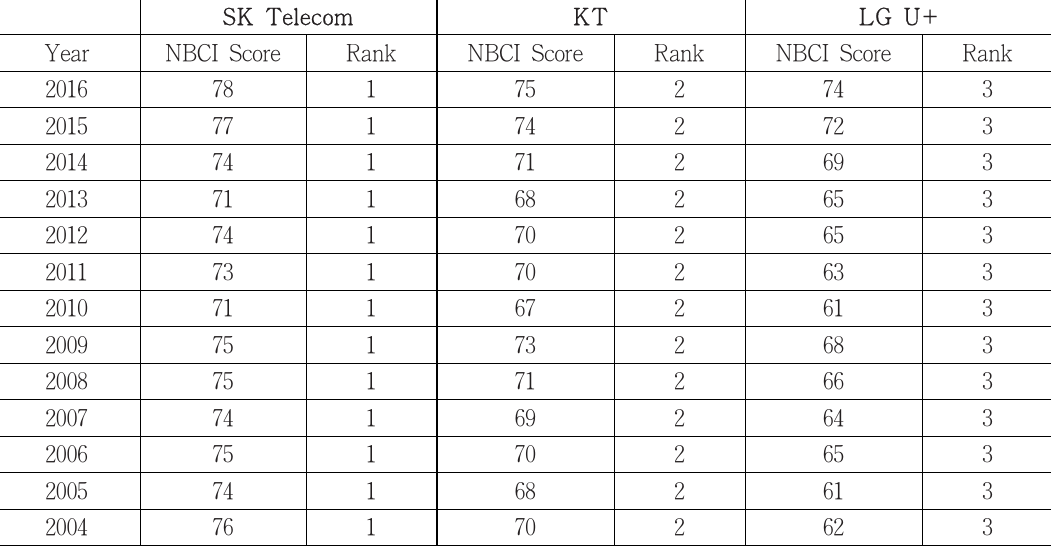
<Table 1> NBCI scores and ranks in the mobile market in Korea, KPC